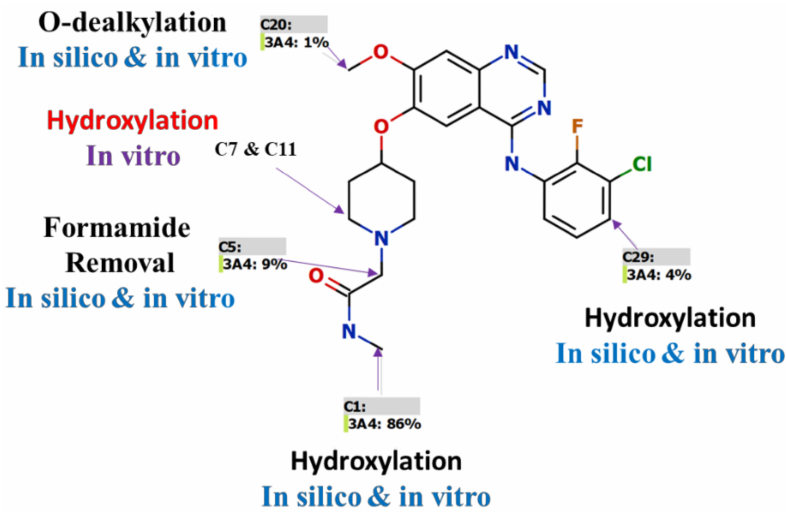
Figure 6. The STP metabolic soft spots that were identified by in silico software and confirmed by in vitro metabolic